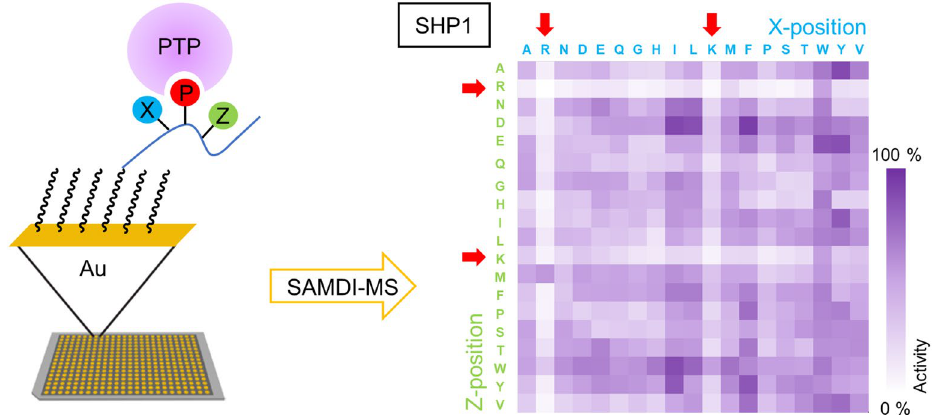
Figure 1. Phosphatase activity profiling using peptide arrays and SAMDI mass spectrometry. (Left) Peptides immobilized on a self-assembled monolayer against a background of tri(ethylene glycol) groups. The array is treated with PTP and dephosphorylation of each peptide is then analyzed with SAMDI-MS. (Right) Heatmap for SHP1 shows basic residues adjacent to phosphotyrosine inhibit enzymatic activity.